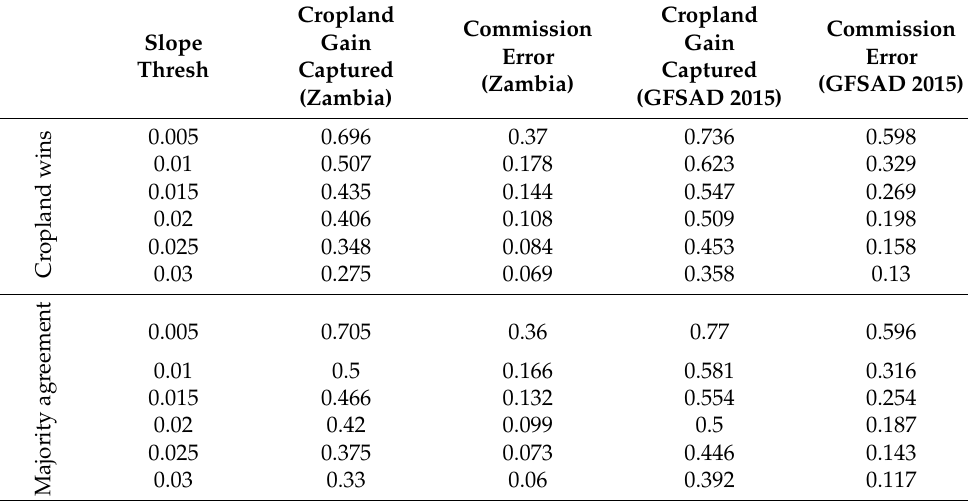
Table 3. The percentage of actual cropland gain (per the reference sample, refer to Section 2.3.4) cap- tured by the mapped cropland gain by slope threshold, along with the commission error (commission error represents areas that did not have cropland gain but were mapped as such).